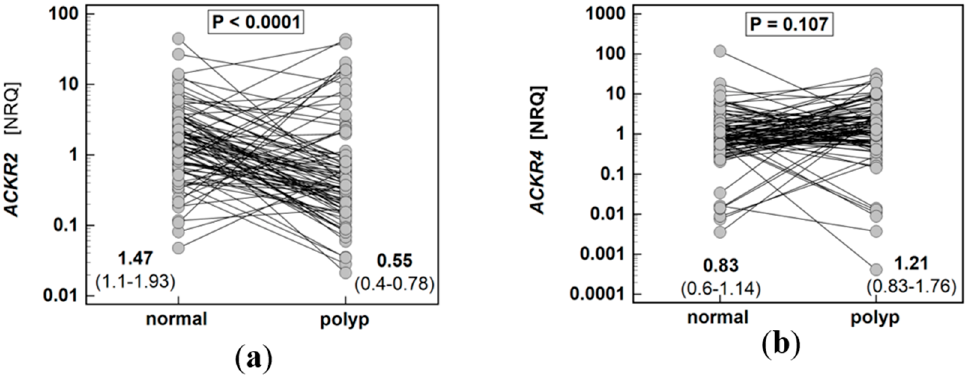
Figure 1. Expression of atypical chemokine receptors (ACKR) in colorectal polyps: ( a ) ACKR2; ( b ) ACKR4. Data presented as dot-plots and mean (95% confidence interval) and analyzed using t-test for paired samples. NRQ, normalized relative quantity.